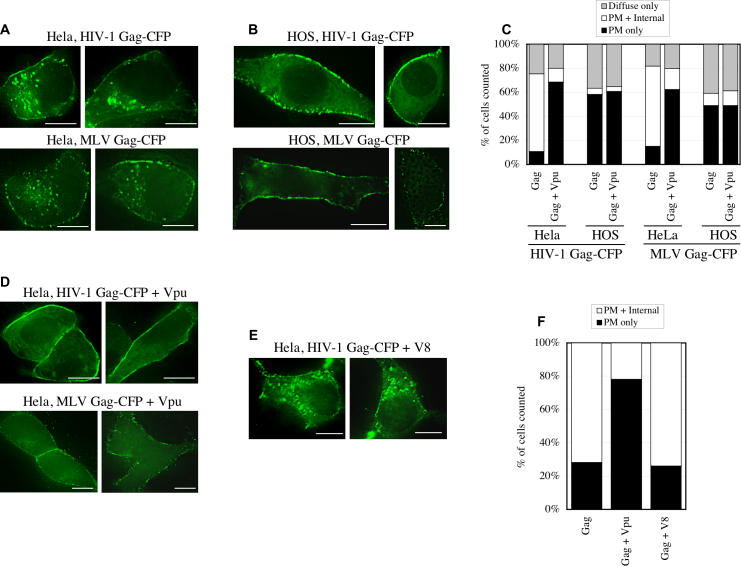
Expression of Vpu Prevents Intracellular Accumulation of Retroviral Gag-CFP Fusion Proteins in HeLa CellsCells were transfected with the indicated expression vectors, fixed 18 h after transfection, and observed by deconvolution microscopy.(A and B) Localization of HIV-1 Gag-CFP or MLV Gag-CFP in HeLa cells (A) or HOS cells (B) in the absence of Vpu. Two examples of each cell type and each Gag-CFP protein are shown. White bars in the micrographs indicate a distance of 10 μm.(C) Quantitative analysis of these effects. Ten random fields of HeLa and HOS cells expressing HIV-1 or MLV Gag-CFP proteins in the presence or absence of Vpu were inspected, and the numbers of cells in which Gag-CFP was observed as accumulations at the PM only (black bars), at intracellular sites as well as at the PM (white bars), or as diffuse cytoplasmic fluorescence only (grey bars) were counted. Enumeration of cells with each pattern of Gag-CFP localization is expressed as a percentage the total of the cells counted, which was 75 ± 7 for each condition and is a representative example of three separate experiments.(D) Examples of HeLa cells expressing HIV-1 Gag-CFP (upper panels) or MLV Gag CFP (lower panels) in the presence of co-expressed Vpu.(E and F) The Vpu TM domain is required to prevent intracellular accumulation of HIV-1 Gag-CFP. (E) Examples of HeLa cells expressing HIV-1 Gag-CFP and V8. White bars in the micrographs indicate a distance of 10 μm. (F) Cells expressing HIV-1 Gag-CFP only, Gag-CFP and Vpu, or Gag-CFP and V8 were inspected and enumerated as described in (C), except that cells containing only diffuse Gag-CFP and no visible accumulations were excluded from the analysis.